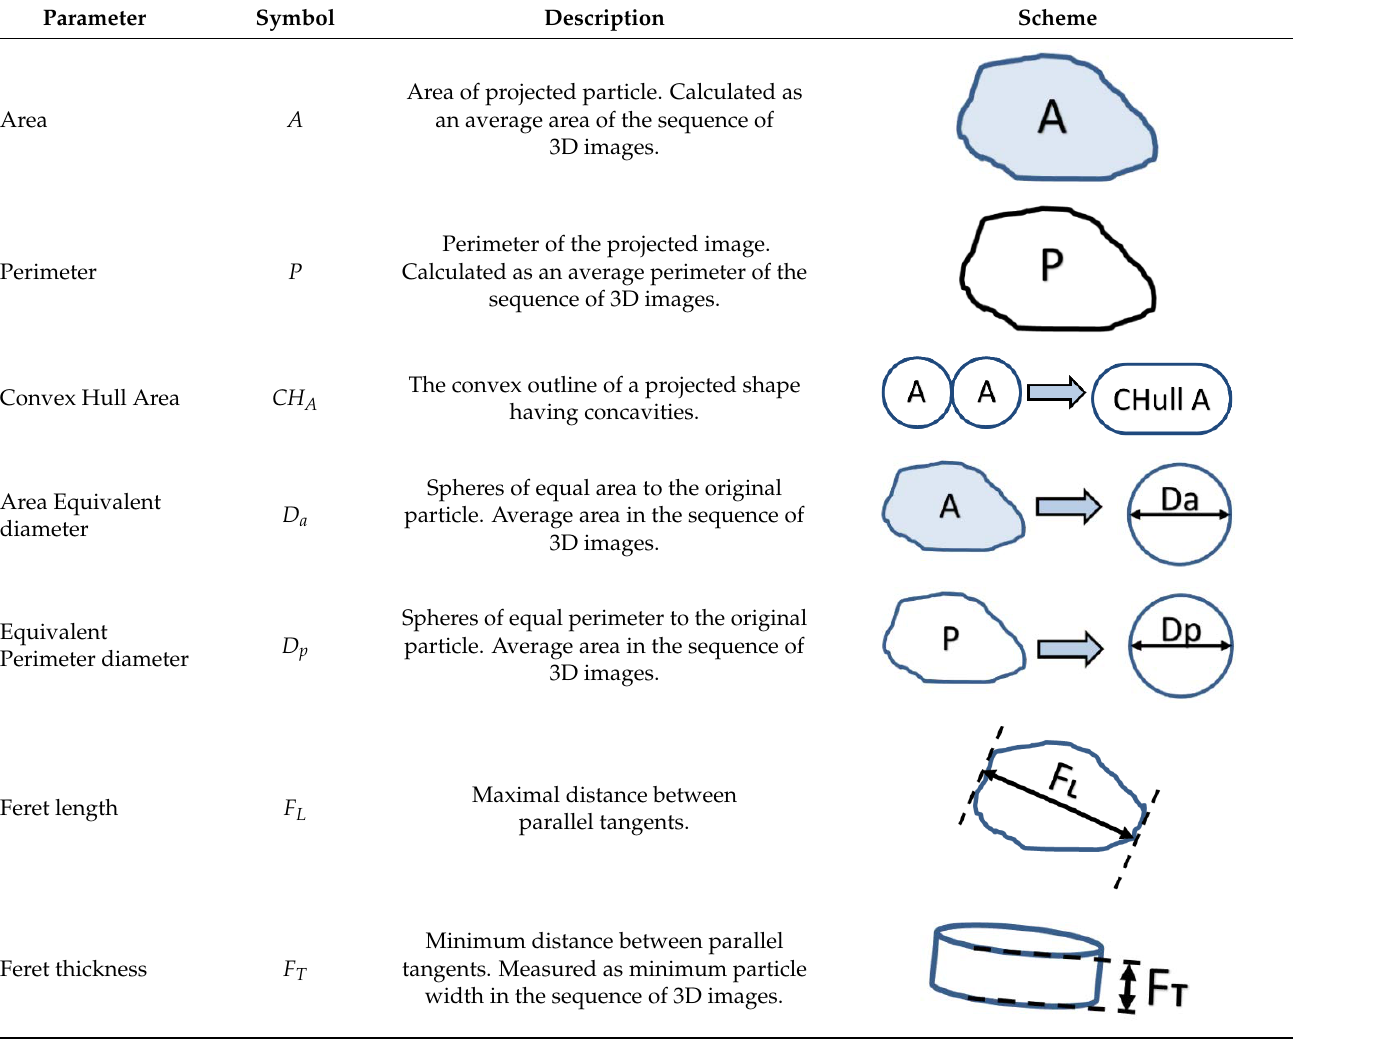
Table 1. Description of size parameters used in 3D Dynamic image analysis.